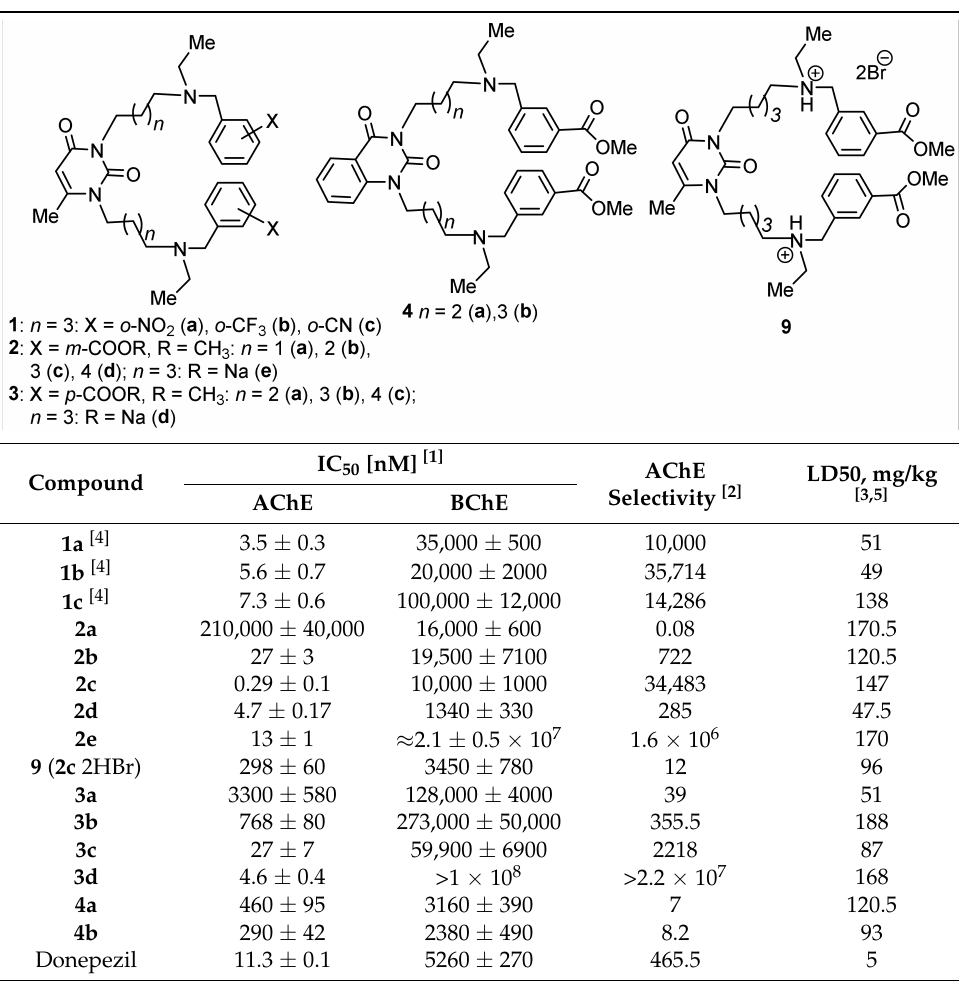
Table 1. In vitro inhibition of human AChE and BChE by compounds with 6-methyluracil, quinazoline-2,4-dione moieties, varied polymethylene chains, and substituents at benzene rings compared to donepezil